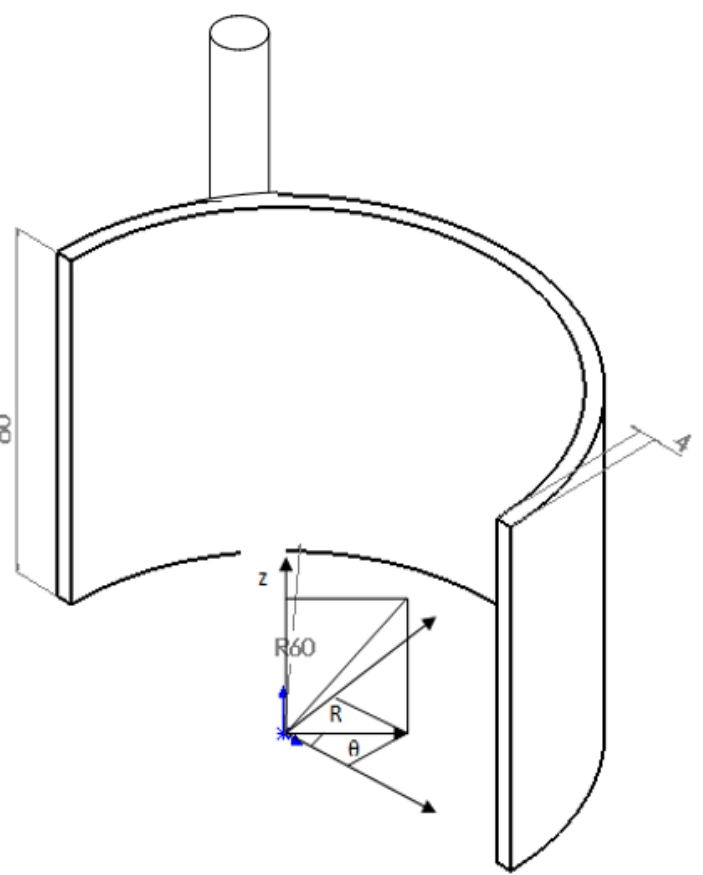
Figure 1. Cutting the bending thin-walled part model.